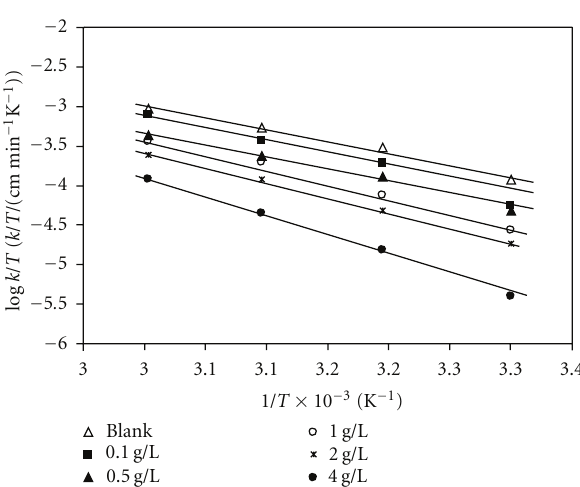
Figure 5: Eyring transition state equation for the mild steel in 5M H 2 SO 4 in the absence (Blank) and presence of